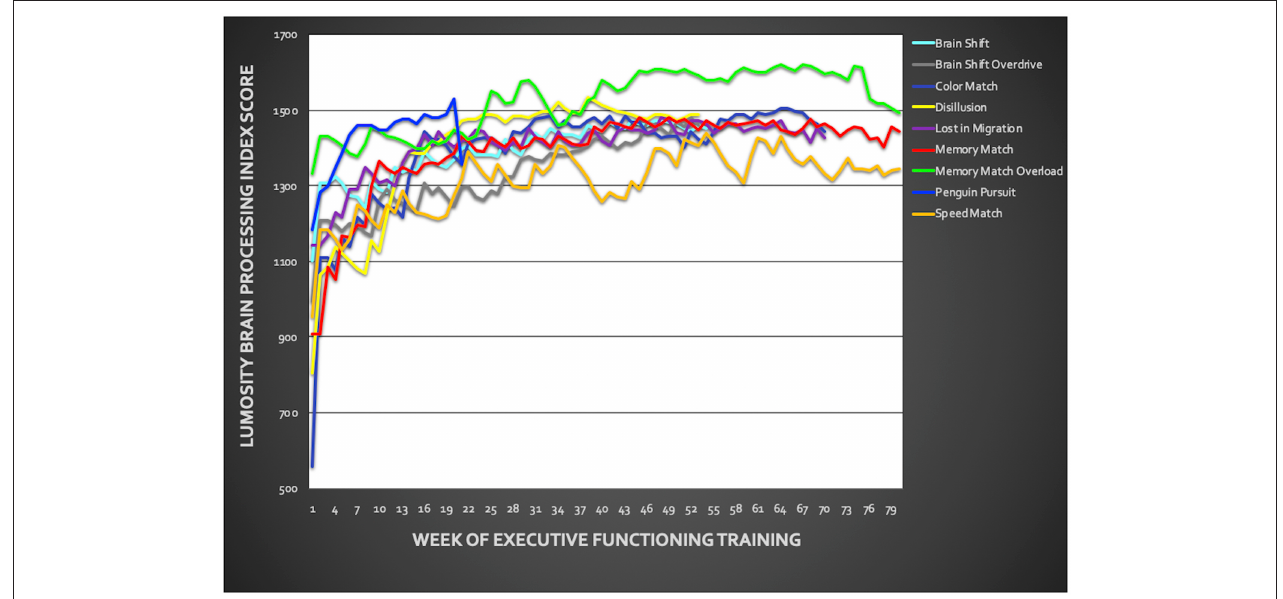
FIGURE 3 | Training performance throughout the six-week executive function training. Training included the following Lumosity TM tasks: Color Match and Lost in Migration, Brain Shift, Brain Shift Overdrive, Speed Match, Memory Match, Memory Match Overload, Penguin Pursuit, and Disillusion. Overall, veterans showed improvement across all training tasks.